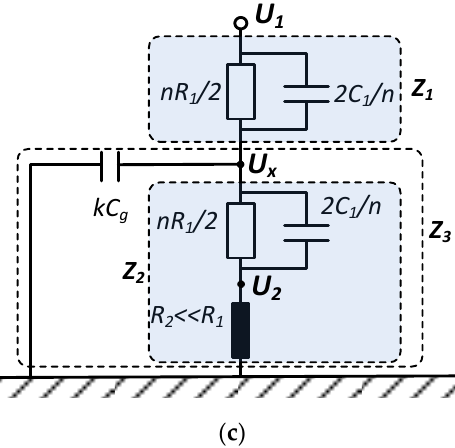
Figure 1. ( a ) Circuital model of the resistive divider, including the distributed stray capacitances C gi between the divider and ground, ( b ) Equivalent circuit of the resistors including the effect of their own capacitance C 1 , ( c ) Equivalent circuit (circuital model) with concentrated stray capacitances to ground of a network of series-connected resistors, where theoretically k = 0.67 for equal response times, and k = 0.44 for equal bandwidth when enclosed in a metallic cylindrical shield [24,29].